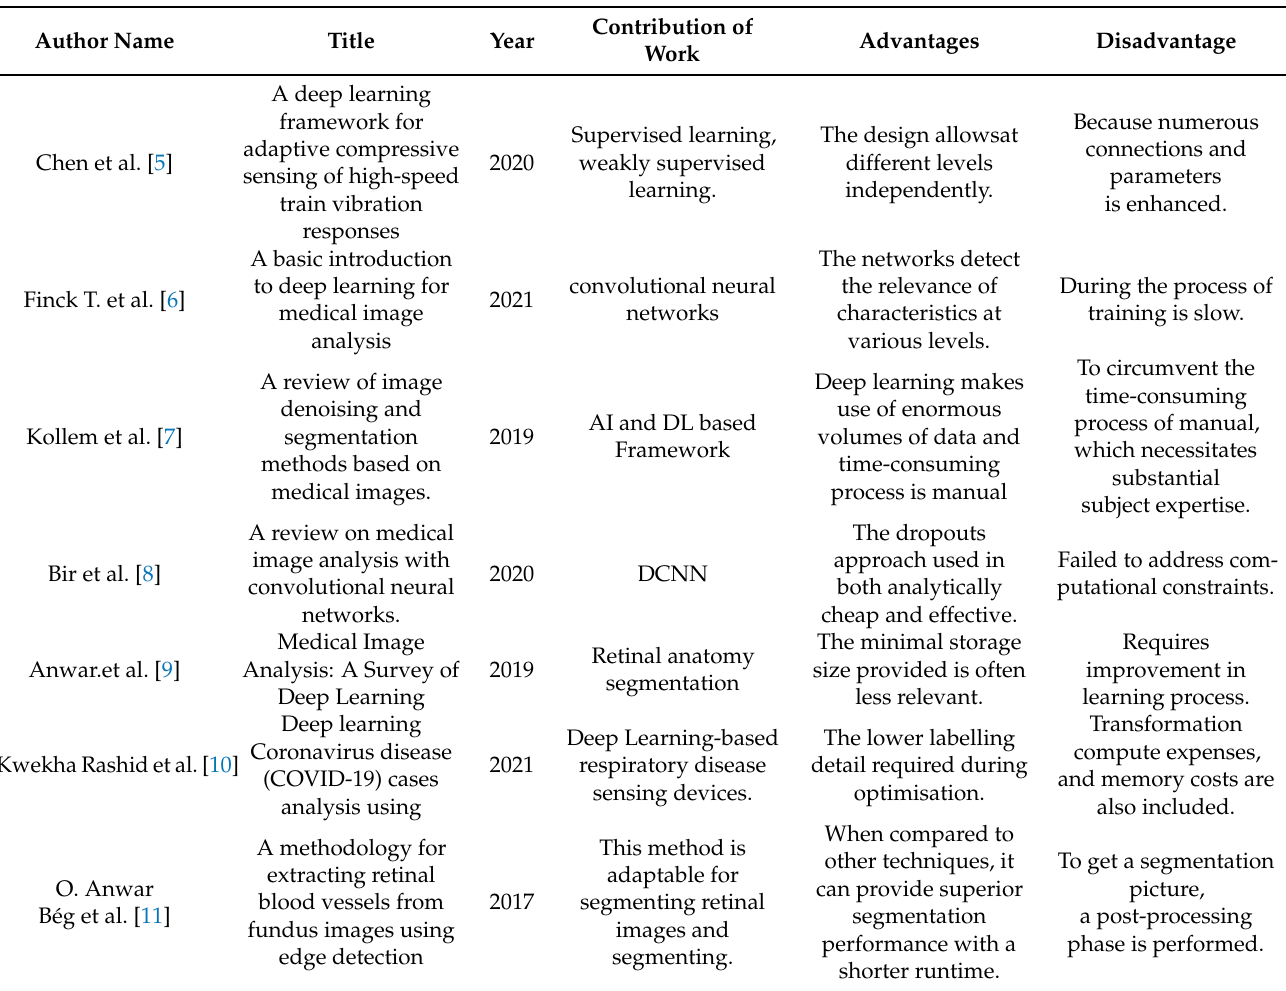
Table 1. Literature survey in deep